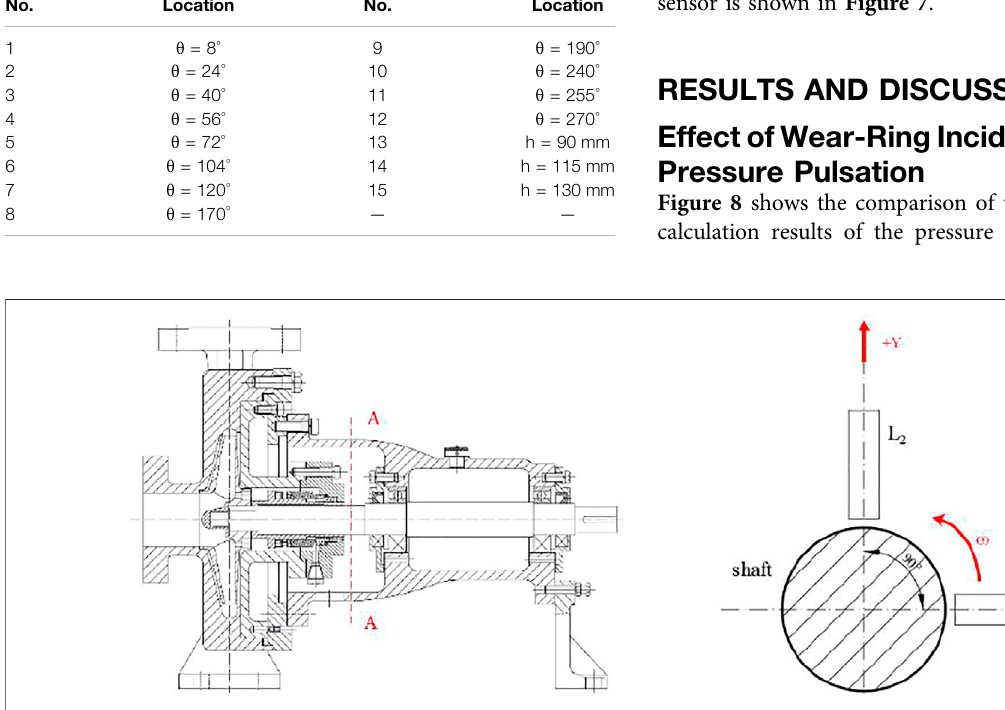
FIGURE 7 | Schematic diagram for installation of vibration displacement